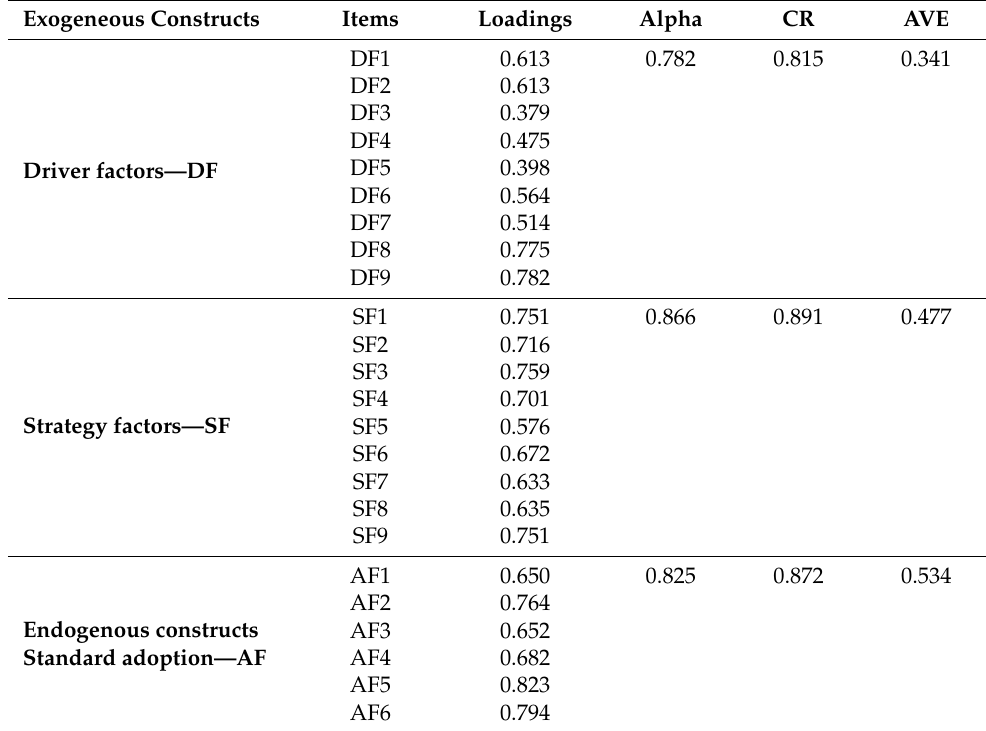
Table 3. Result of measurement model—convergent validity.